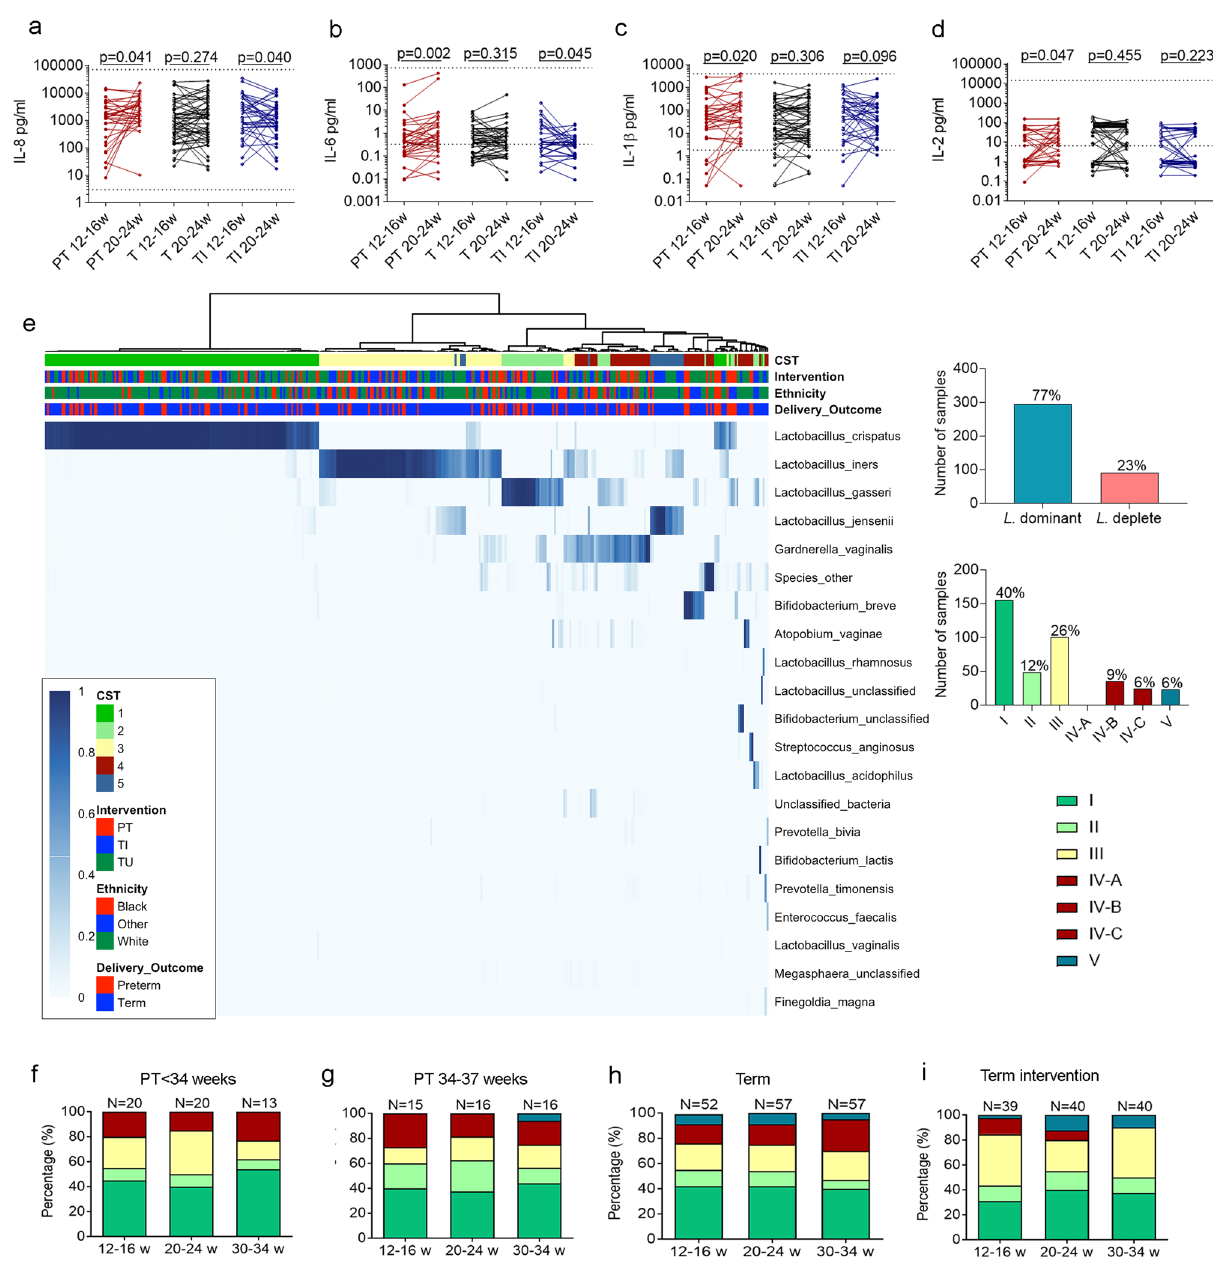
Fig. 2 Cervicovaginal pro-in fl ammatory cytokines increase in mid-pregnancy in women who deliver preterm and early-preterm birth is associated with a predominance of Lactobacillus Iners or diverse vaginal microbial composition compared to late preterm birth. Longitudinal sampling of cervicovaginal cytokines was performed in 122 women, of whom 34 delivered preterm, 51 delivered at term without intervention, and 37 delivered at term with an intervention. Concentrations of IL-8 ( a ), IL-6 ( b ), IL-1 β ( c ), and IL-2 ( d ) taken at 12 – 16 weeks and 20 – 24 weeks are presented. A one-sided Wilcoxon matched pairs signed rank was used for statistical analysis. A heat map shows the distribution of community state types (CST) of studied women, with graphs representing the percentages of samples classed as Lactobacillus dominant ( n = 295) and Lactobacillus deplete ( n = 90), or classed by vaginal microbial composition; CST I ( L. crispatus ) ( n = 155), CST II ( L. gasseri ) ( n = 48), CST III ( L. iners ) ( n = 100), CST IV (diverse) subdivided into CST IV-A ( n = 0), CST IV-B ( n = 35), CST IV-C ( n = 24), and CST V ( L. jensenii ) ( n = 23) , a total of = 385 samples. e Vaginal microbial composition at each timepoint is presented in women who delivered <34 weeks ( f ), 34 – 37 weeks ( g ), at term without intervention ( h ), and in women who delivered at term following intervention ( i ), n = 133 women with cross sectional data. PT = preterm, T = term without intervention, TI = term with intervention. Source data are provided as a Source Data fi 4 of the 6 women who delivered preterm with CST IV had high preterm delivery is associated with a signi fi cantly greater degree of relative abundance of G. vaginalis . compared to only 3 of the 9 in fl ammation, alluding to a dysregulated immune response. women who delivered at term (Supplementary Data 2). No statistically signi fi cant differences were seen in the concentration of IL-10 (Fig. 3l). These data demonstrate that a degree of microbial-driven in fl ammation occurs regardless of outcome, yet